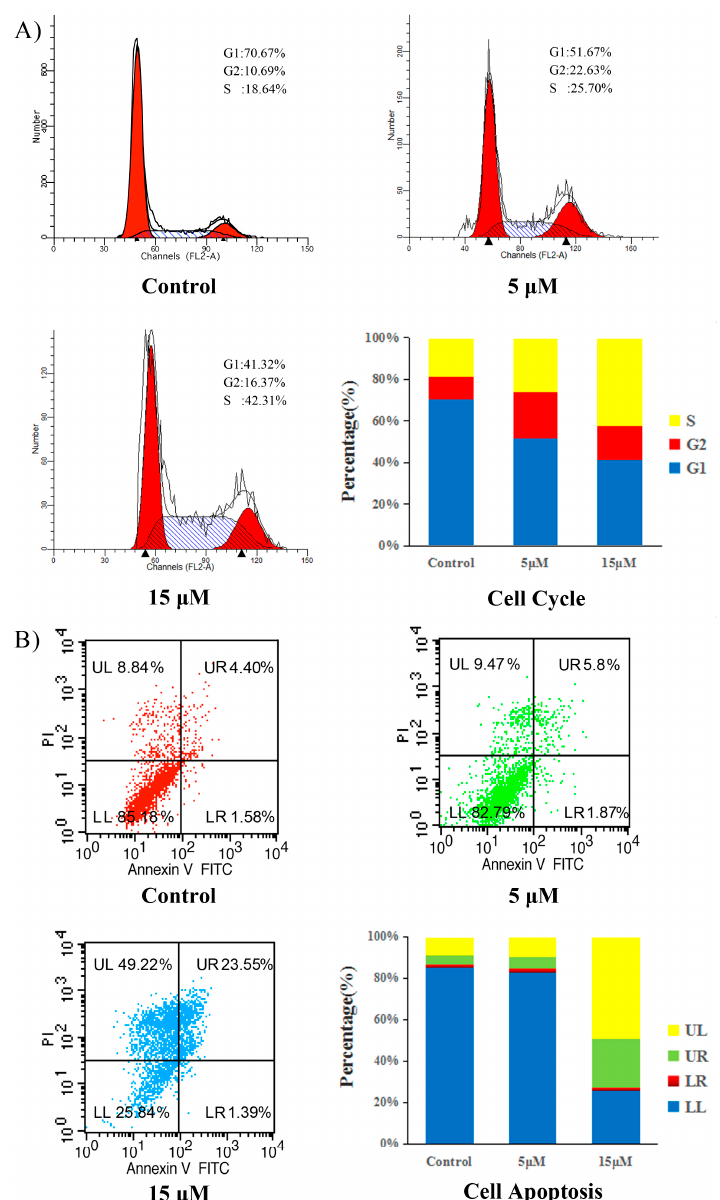
Figure 4. ( A ): Flow cytometry analyses of cell cycle distribution of HCT-116 cells after treatment of compound 5d (5 and 15 µ M) and no treatment (Ctrl) as a reference for 24 h; ( B ): Apoptosis induction in HCT-116 cells after treatment of compound 5d (5 and 15 µ M) and no treatment (Ctrl) as a reference for 24 h.